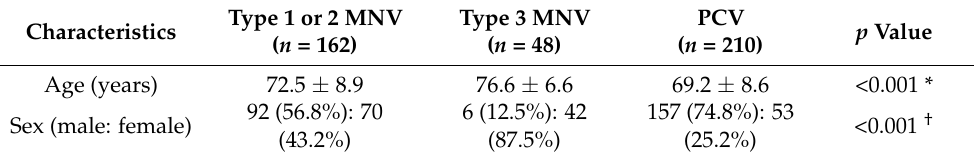
Table 3. Comparisons of characteristics among different types of macular neovascularization.